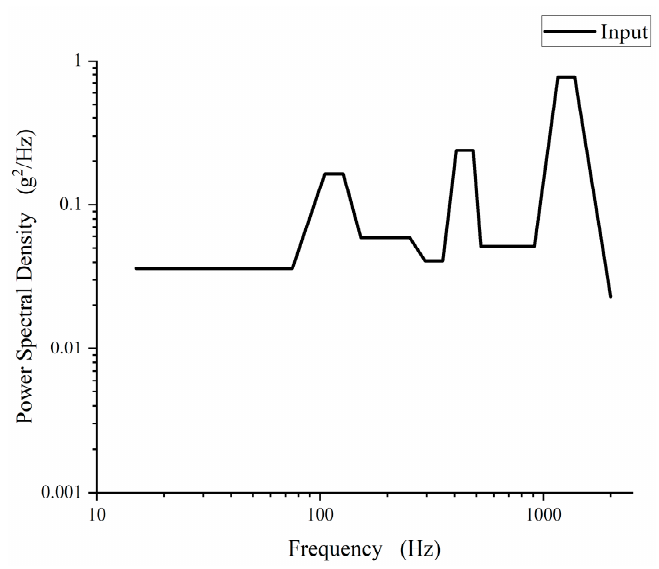
Figure 3. Power density spectrums profile.